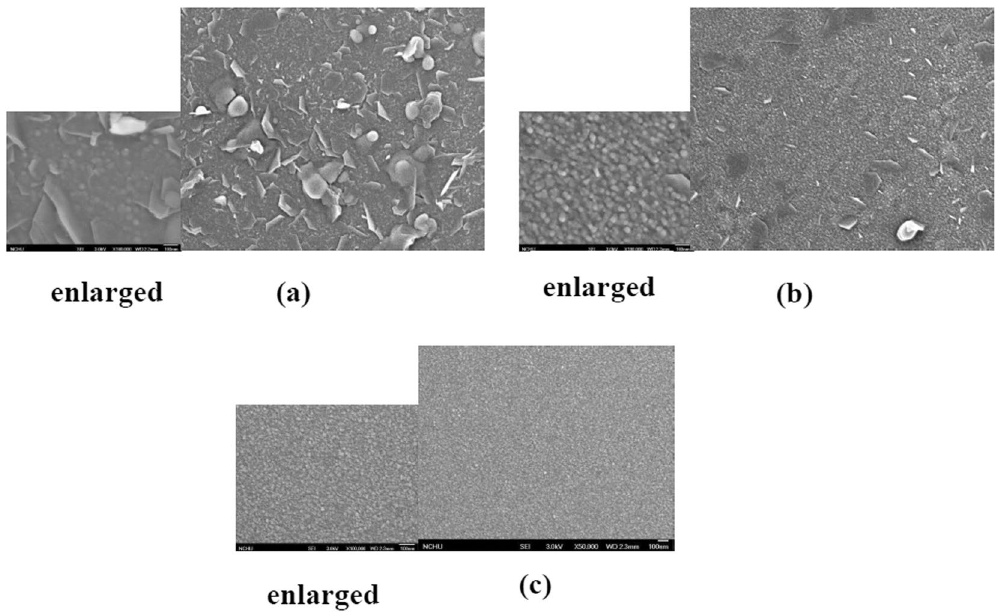
Figure 2. FESEM images of MgO film surfaces for ( a ) the as-deposited sample ( b ) thermal annealed sample ( c ) the sample with CF 4 plasma treatment. (The scale of the normal FESEM images ( a ) and ( b ) is the same as ( c